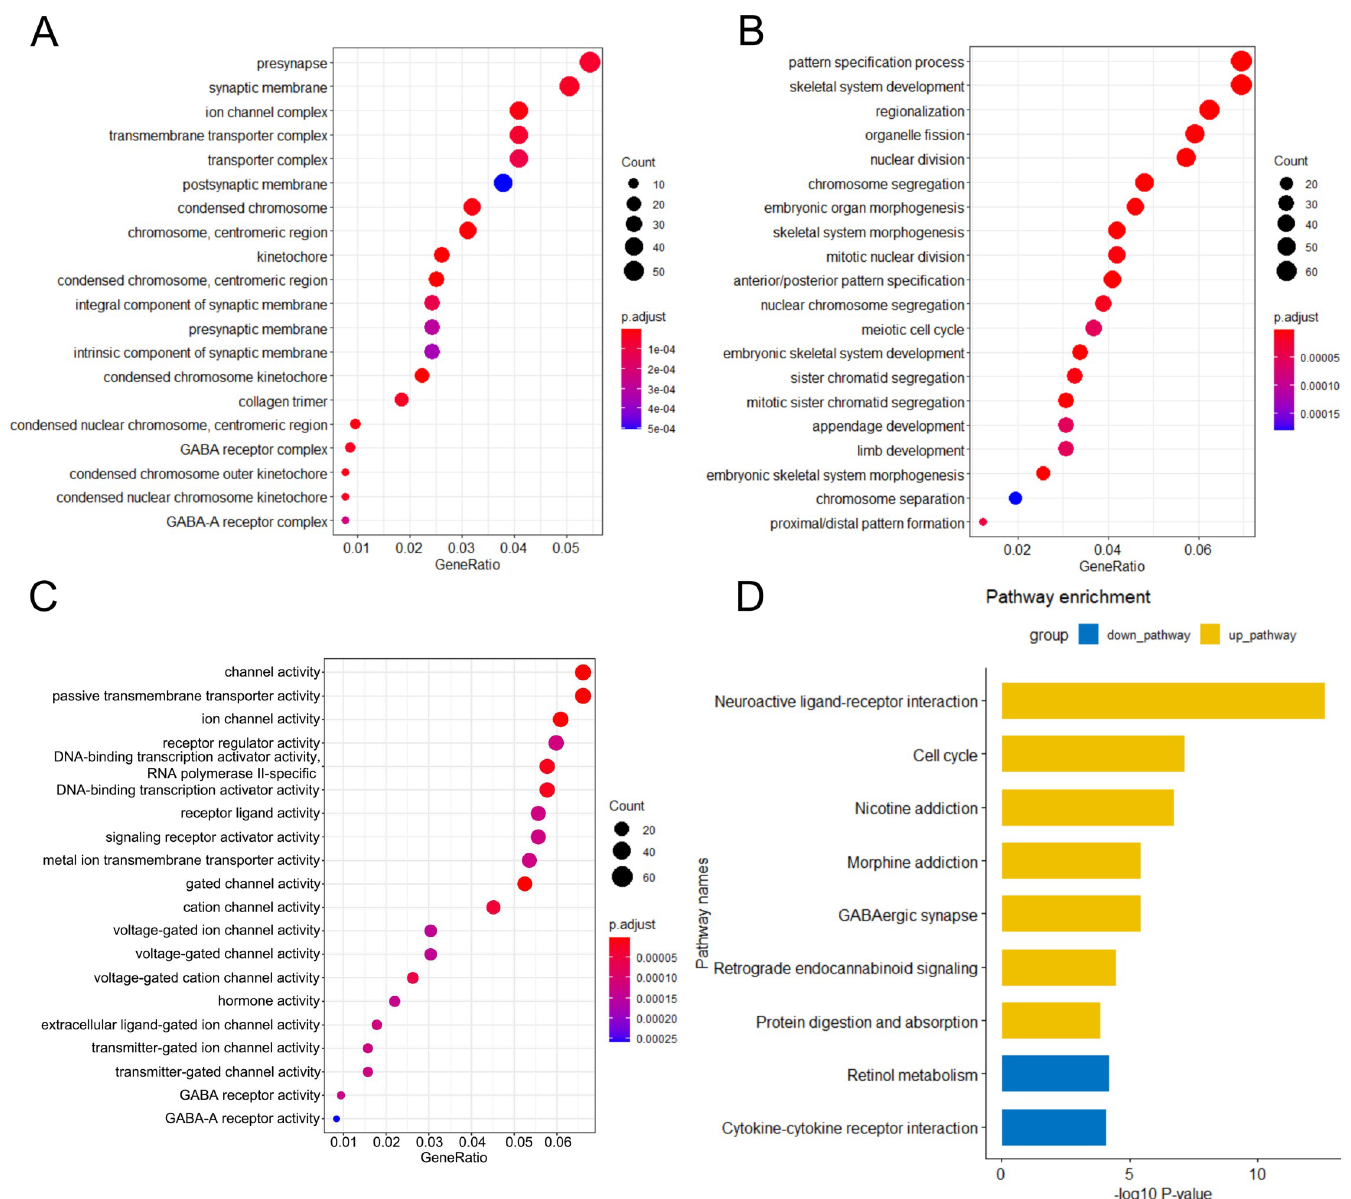
Fig 2. Functional enrichment analysis of differentially expressed mRNAs. The most important GO terms for cell component (A), biological process (B) and molecular function (C) of 1092 differential genes were shown in the figures; D. Gene networks identified through KEGG pathway analysis of the differentially expressed